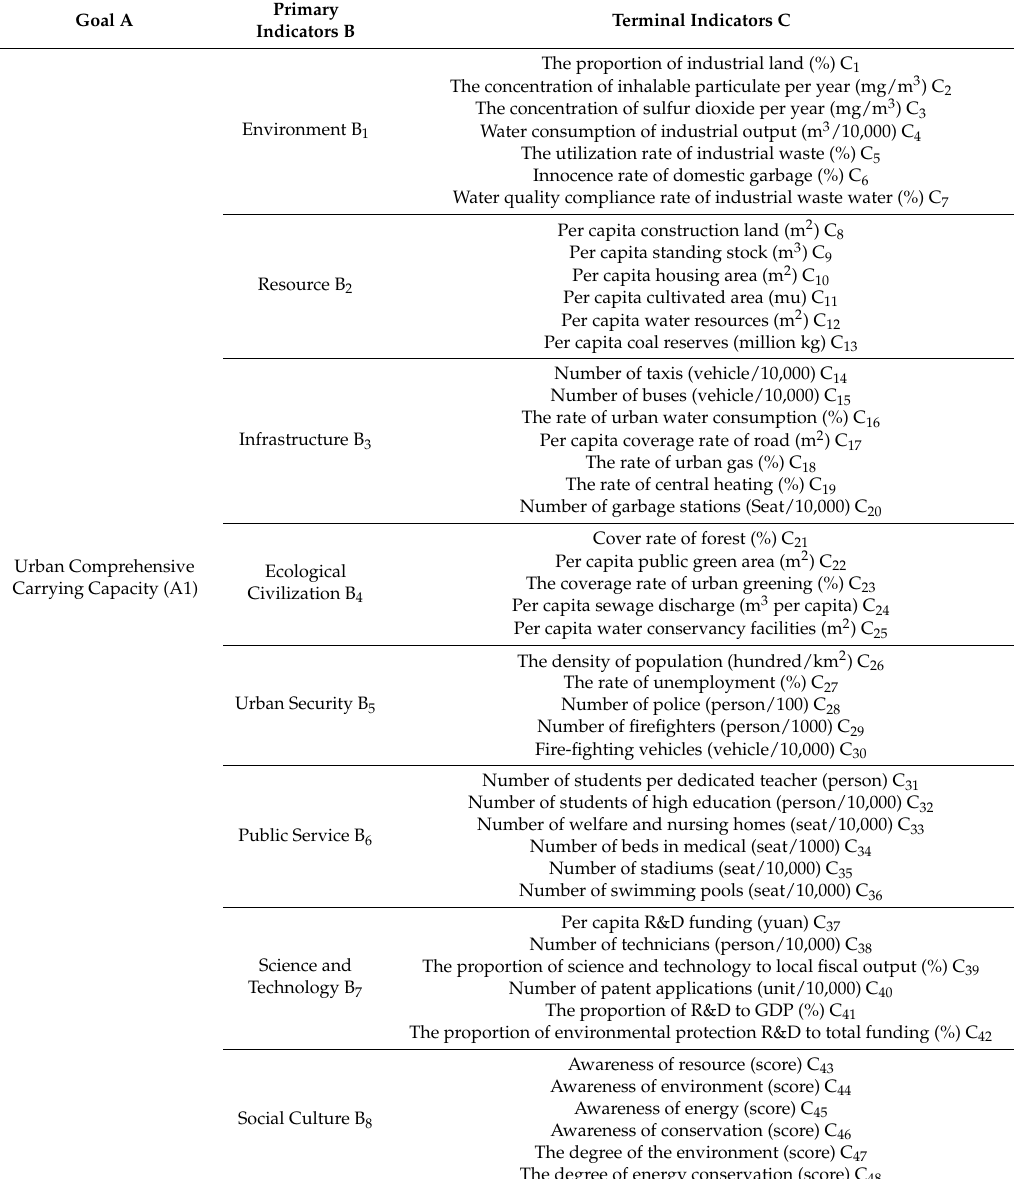
Table 5. The indicator library for the evaluation of urban comprehensive carrying